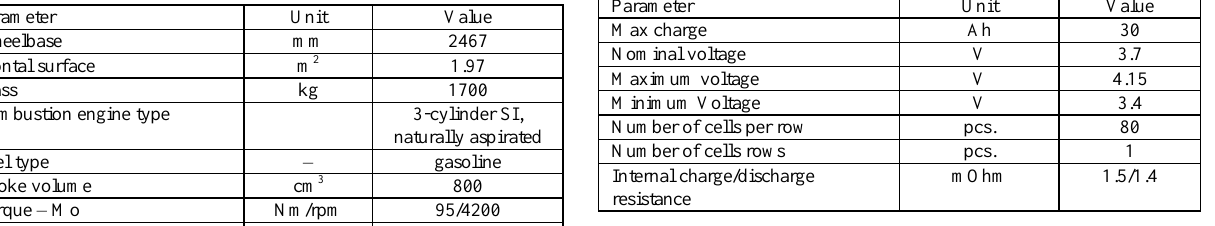
Table 2. Technical parameters of the LNMCO batteries